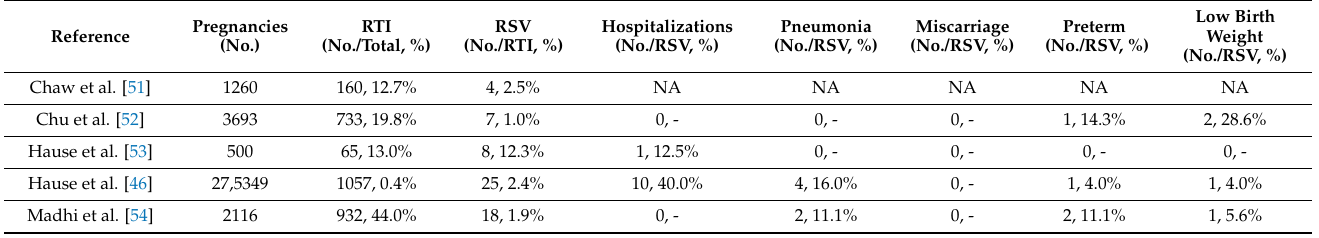
Table 2. Characteristics of the studies included in the quantitative analysis (Note: RSV = Respiratory Syncytial Virus; RTI = Respiratory Tract Infection).